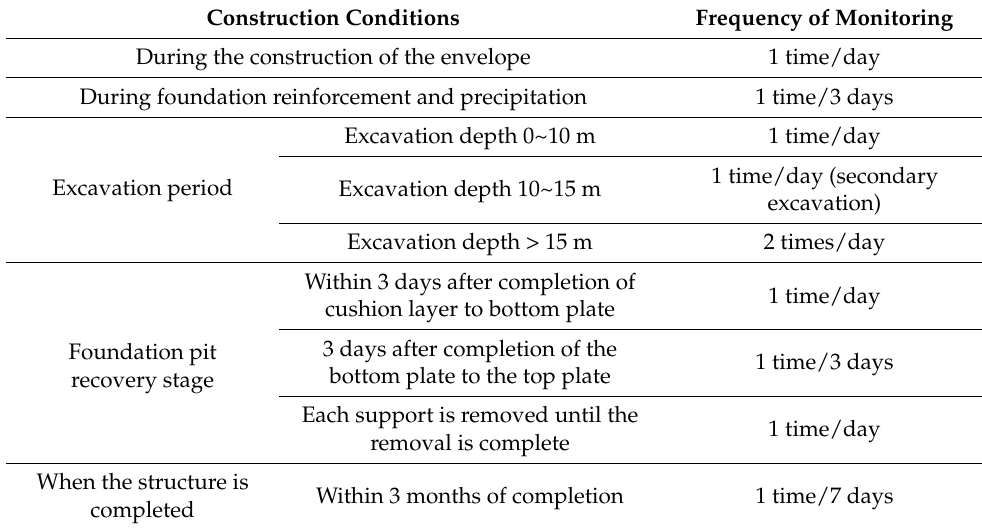
Table 7. Monitoring requirements for steel bracing systems. Construction